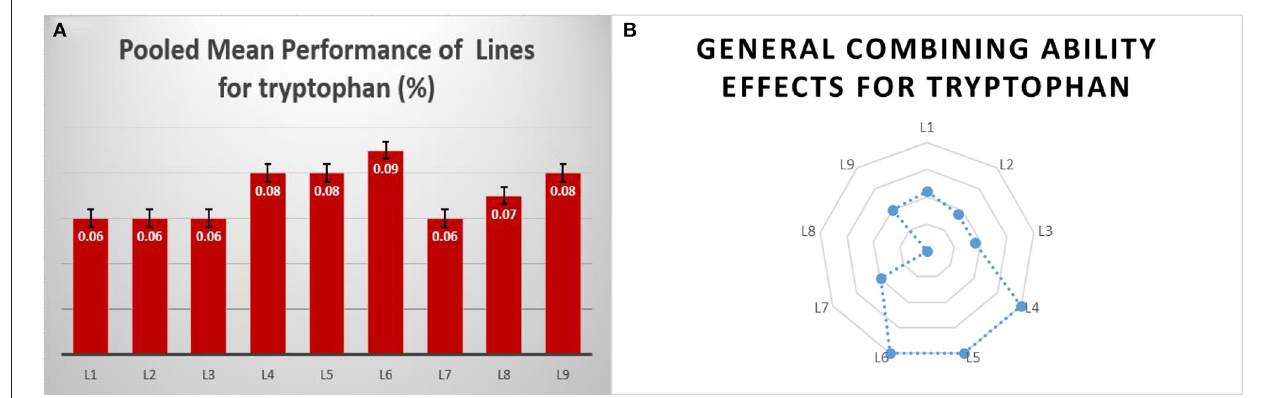
FIGURE 2 | The overall pooled mean performance and general combining ability of female lines for tryptophan. (A) The pooled mean performance of lines for tryptophan content. (B) The general performance of lines in a series of crosses for tryptophan.